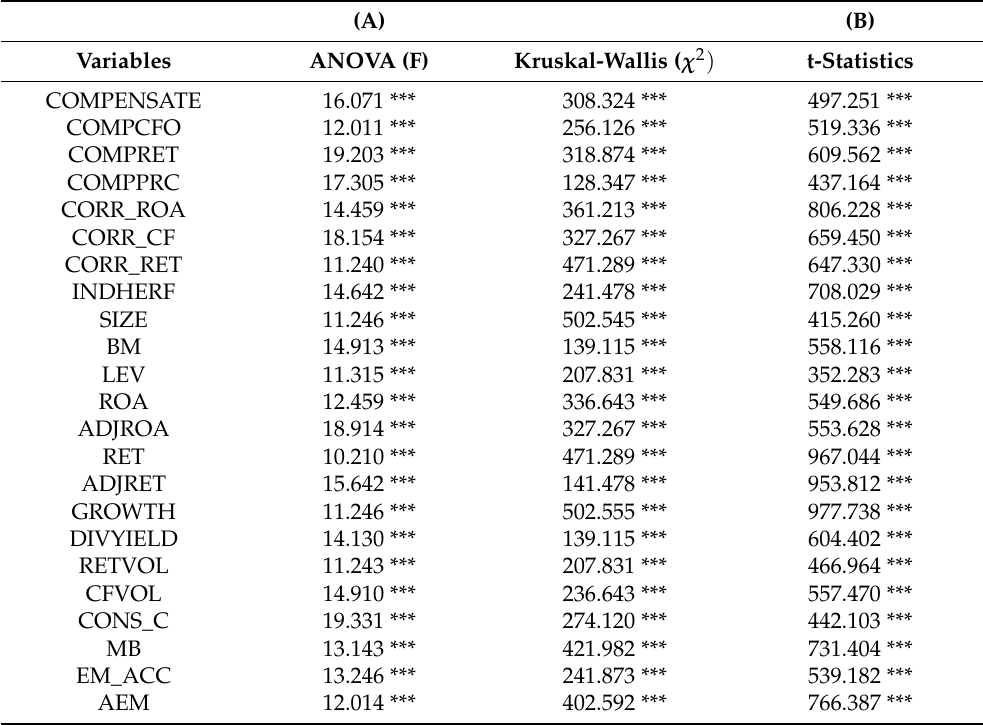
Table 2. Panel A. ANOVA and Kruskal-Wallis of variables across 24 industrial sectors. Panel B. ADF-Fisher, Null: Unit root (assume common Unit root